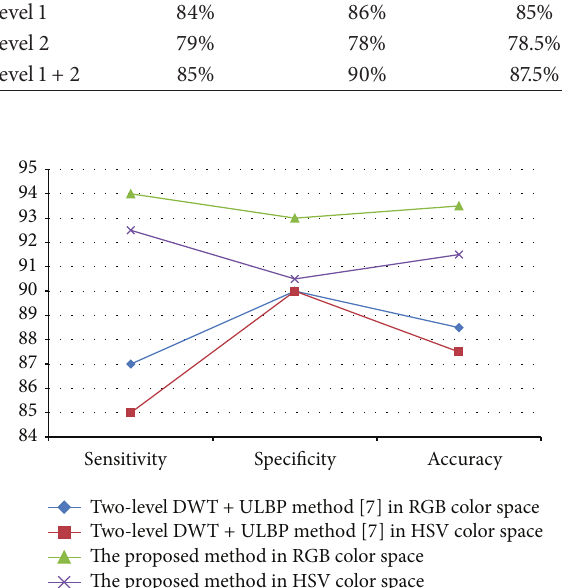
Figure 8: Extracted results from the proposed algorithm and two- level DWT + ULBP method in RGB and HSV color